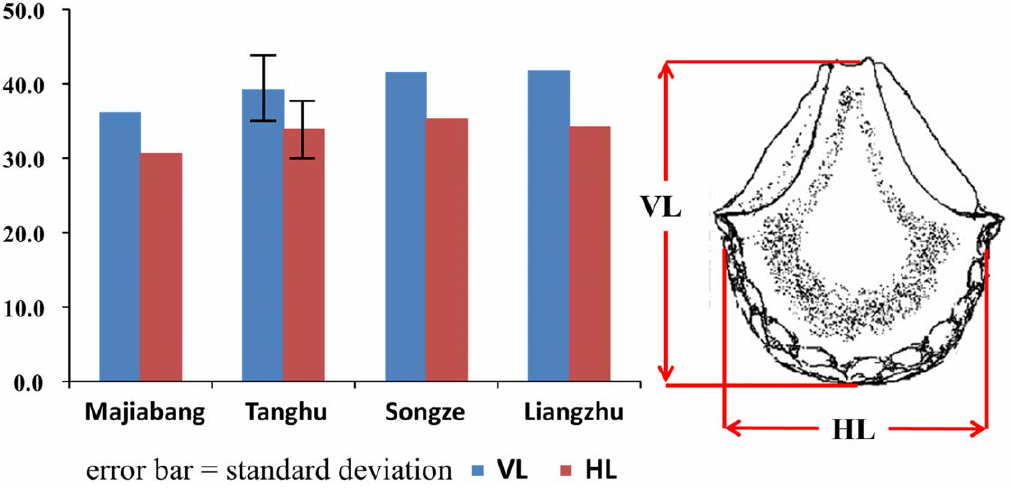
Figure 7. Comparison of morphological characteristics of rice bulliform in difference archaeological sites. The data from the Majiabang, Songze, and Liangzhu Cultures obtained from Zheng et al. [34]. The standard deviations of the references are not provided in the original paper. Phytolith portrait is after Fujiwara [37].